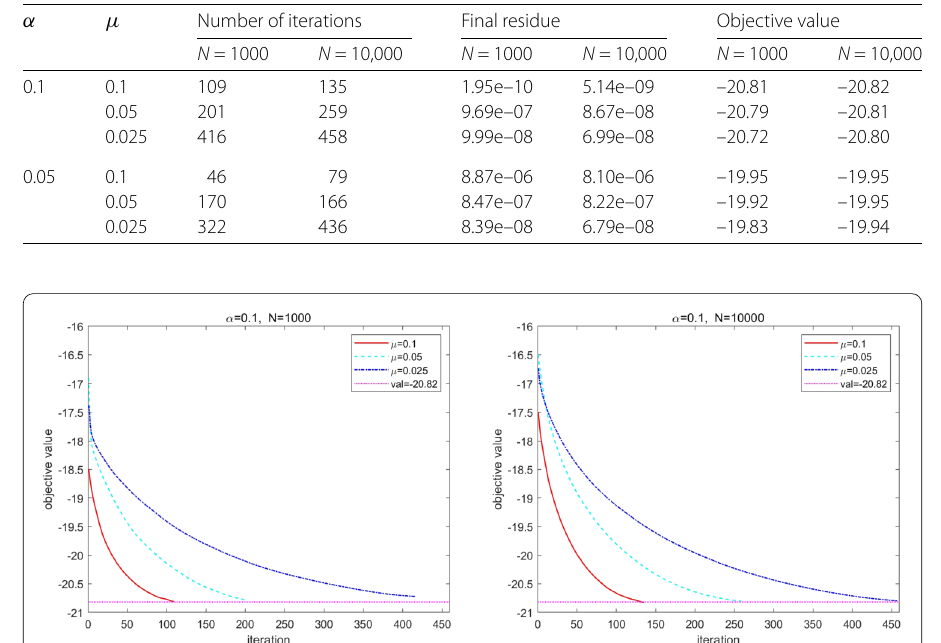
Table 1 Numerical results for different α and μ